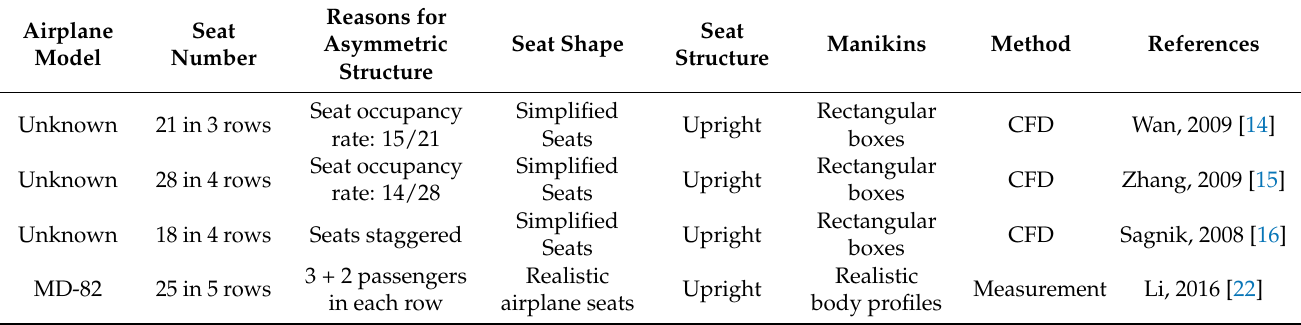
Table 3. Summary of asymmetric seat layouts in representative published